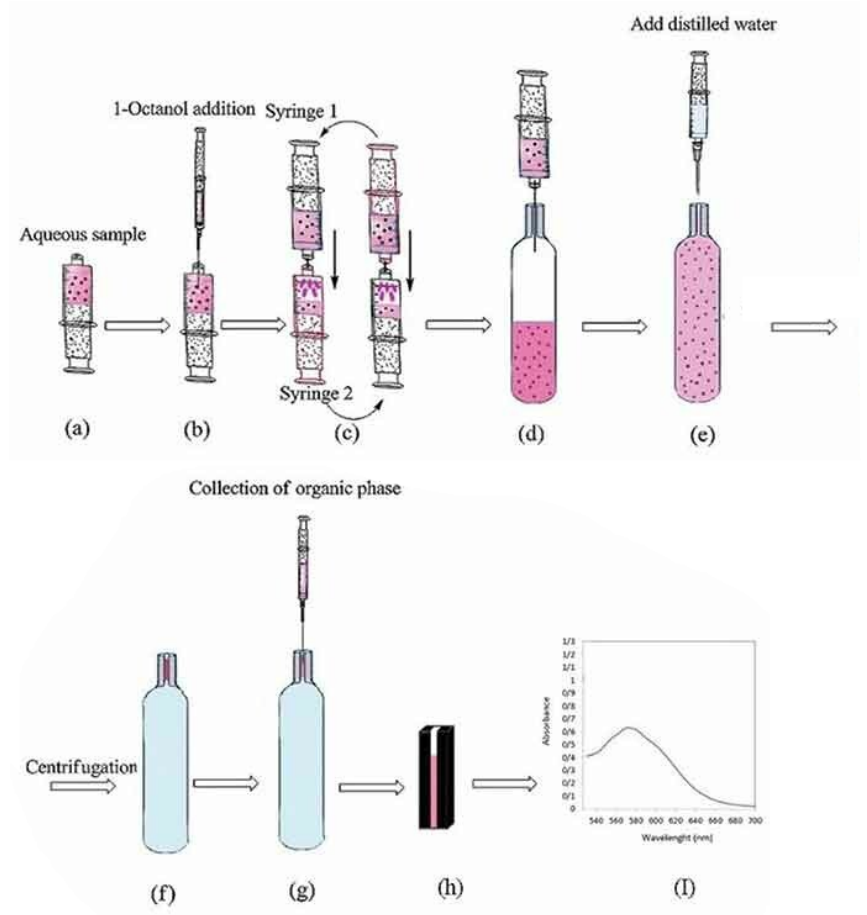
Figure 3. Schematic depiction of a double-syringe liquid microextraction set up for preconcentrating and detecting Hg 2+ ions. Reprinted with the permission of Taylor and Francis from